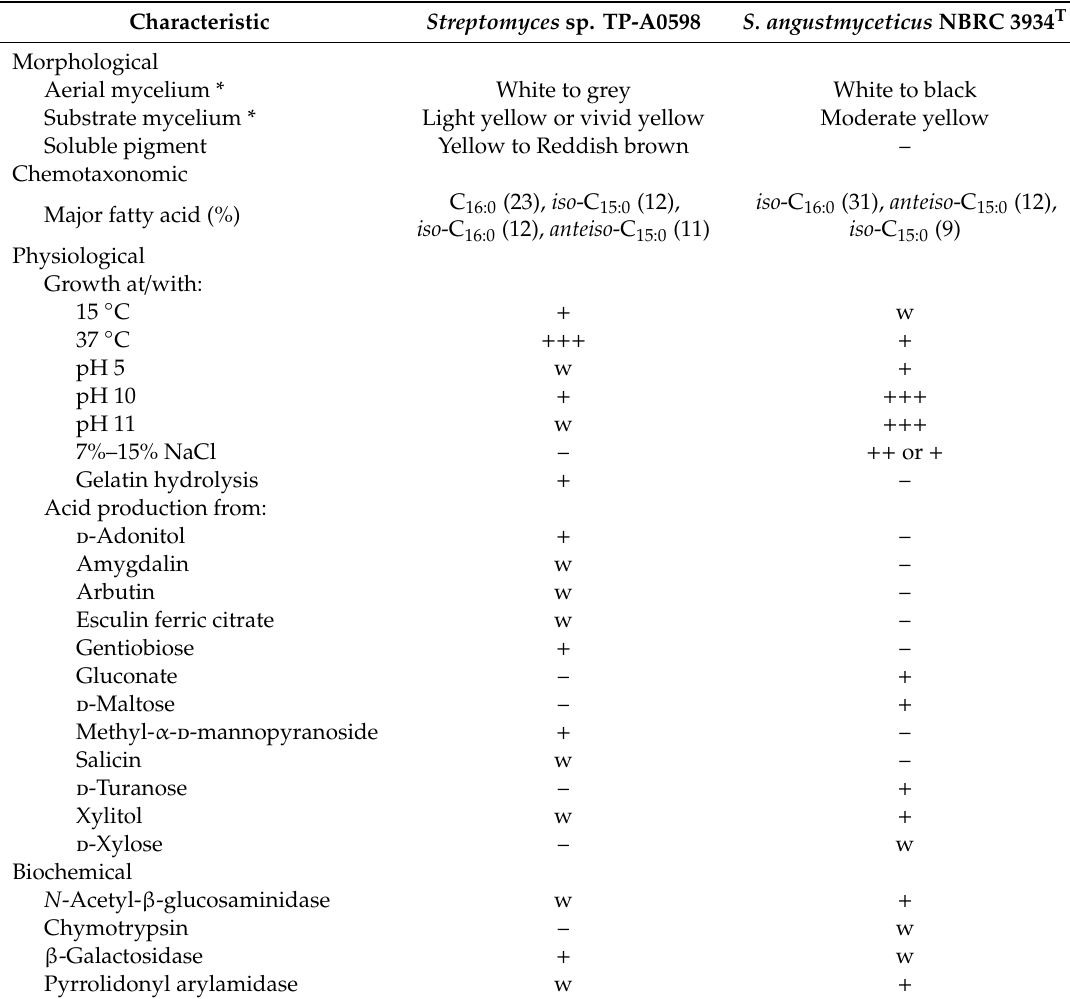
Table 2. Characteristics di ff erent between Streptomyces sp. TP-A0598 and the type strain of its closest phylogenetic